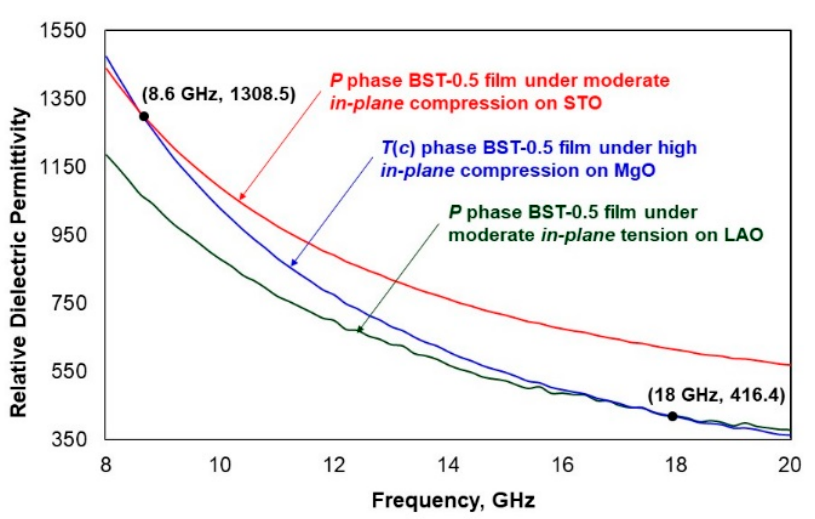
/ , of BST-0.5 ⊥ , of BST-0.5 